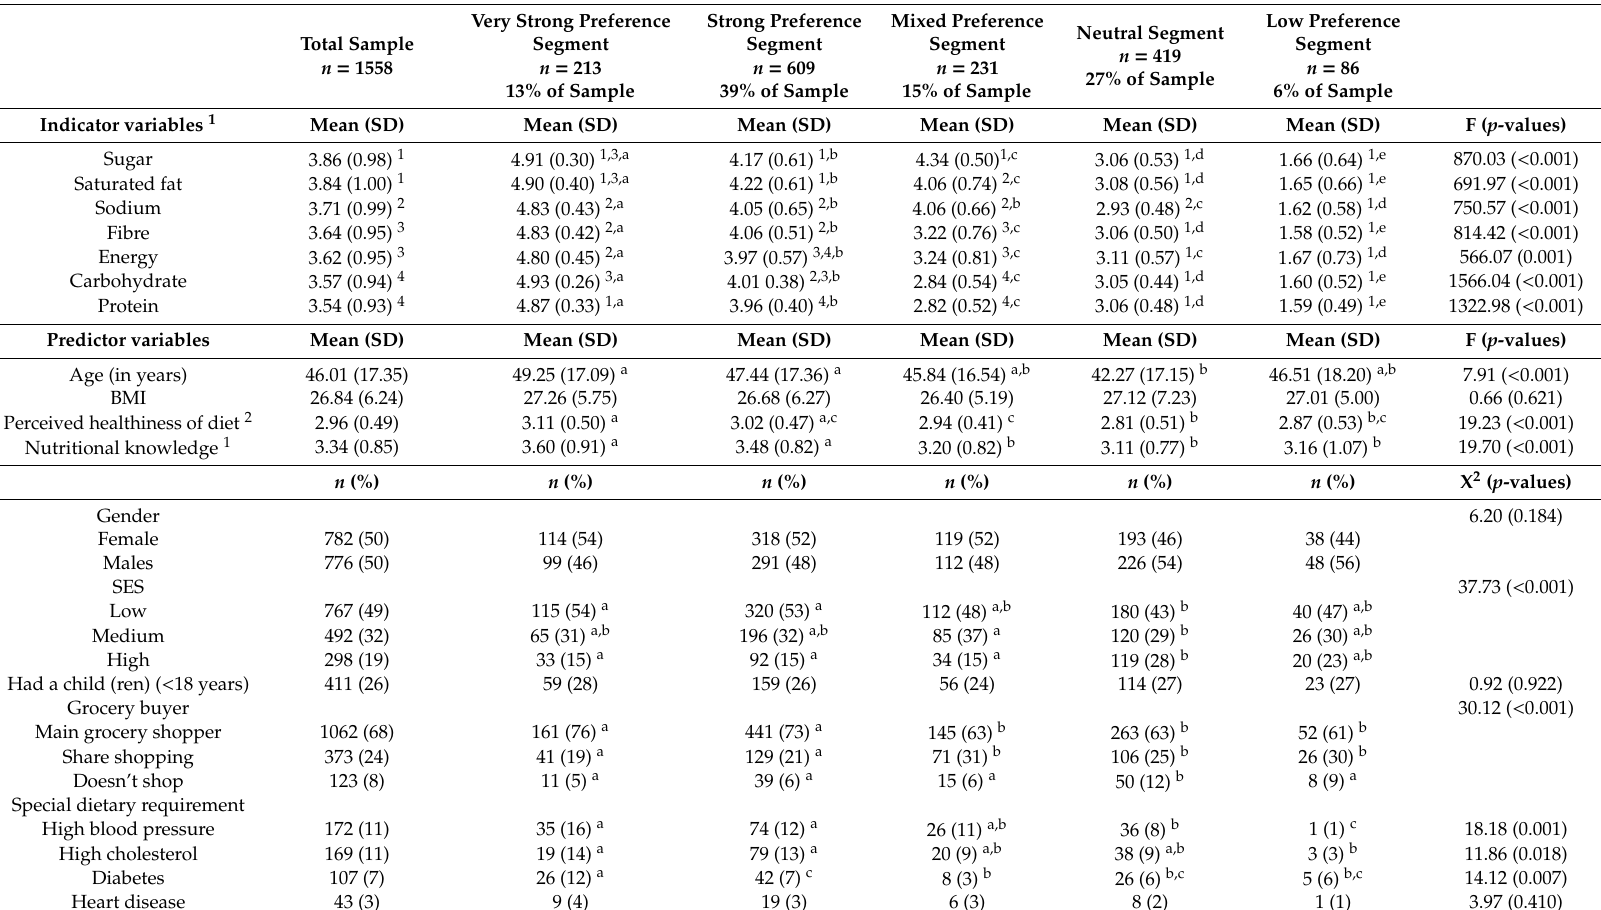
Table 3. Mean comparisons of profile indicators and predictor variables in the 5-segment latent profile